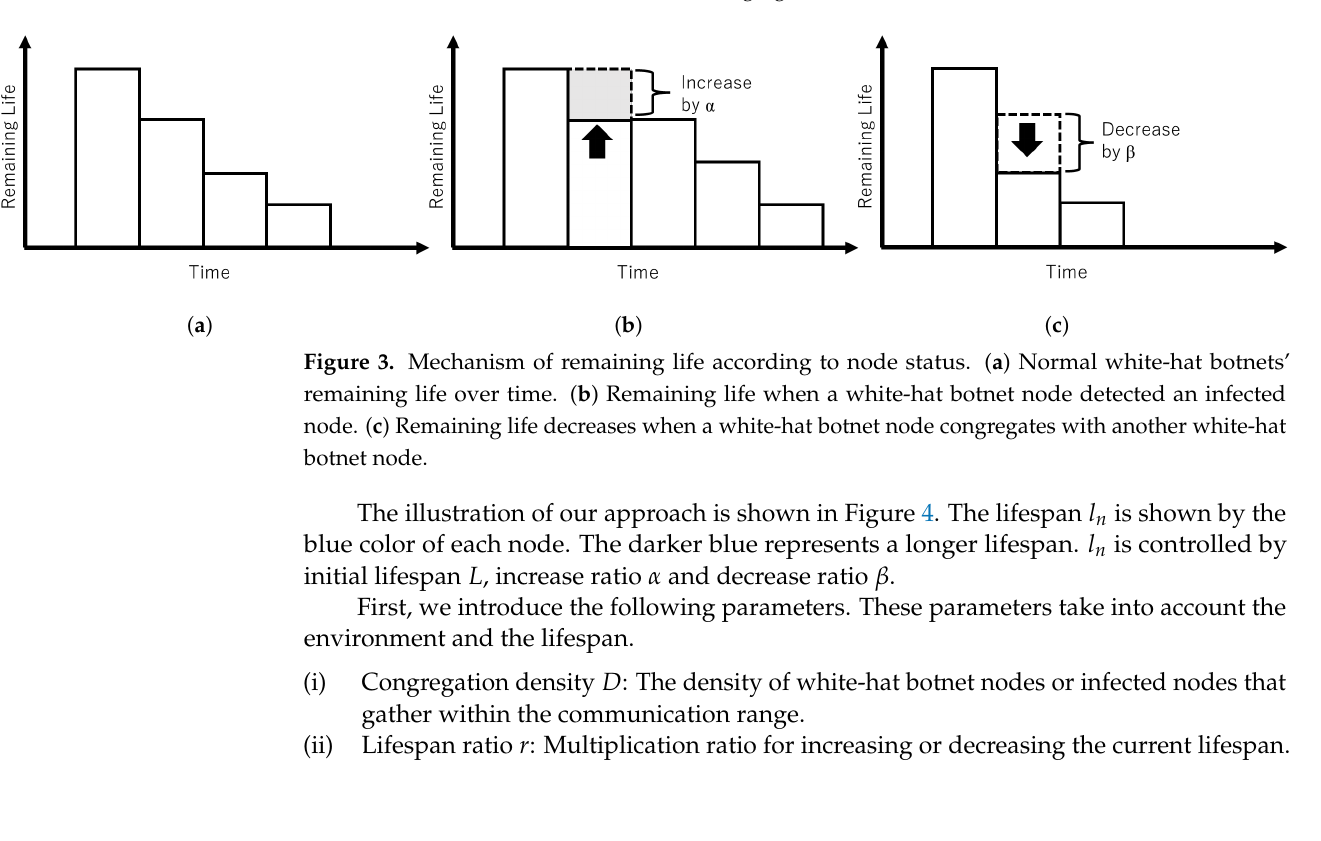
Figure 2. Mechanism of dynamic lifespan that changes according to node status. ( a ) Normal lifespan change. ( b ) Lifespan increases when a white-hat botnet node detected a malware node. ( c ) Lifespan decreases when a white-hat botnet node congregates with another white-hat botnet node.